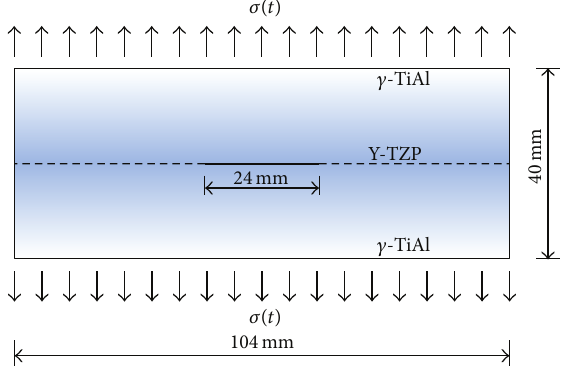
Figure 11: Central-crack functionally graded plate under impact loading.